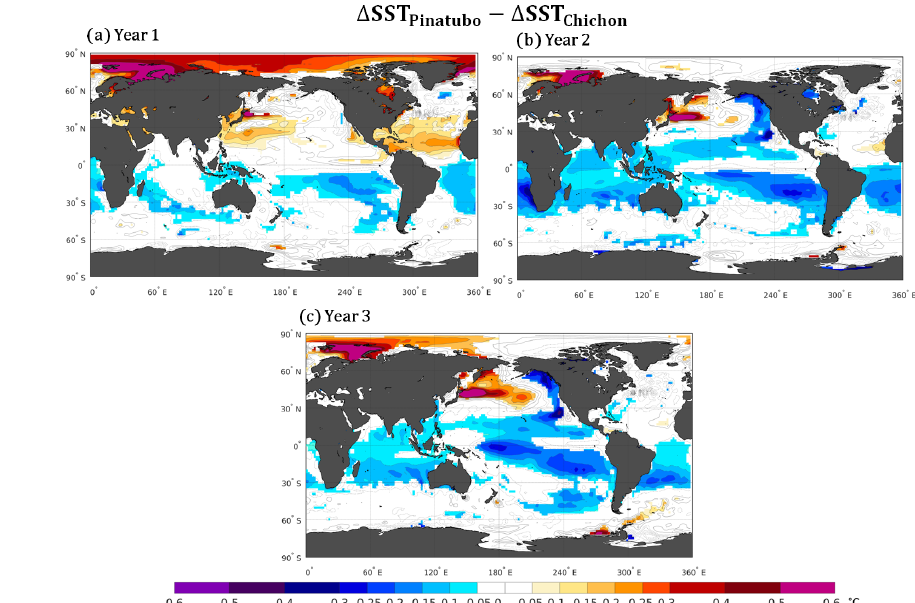
Figure A9. Difference in the ensemble mean sea surface temperature anomalies between the Pinatubo and El Chichón eruptions ( (cid:49) TS Pinatubo − (cid:49) TS Chichón ). Only significant anomalies are shown with an approximate 95% confidence level using Student’s t test. Con- tours show temperature anomalies following the colour bar scale (solid line for positive anomalies and dashed line for negative anomalies).